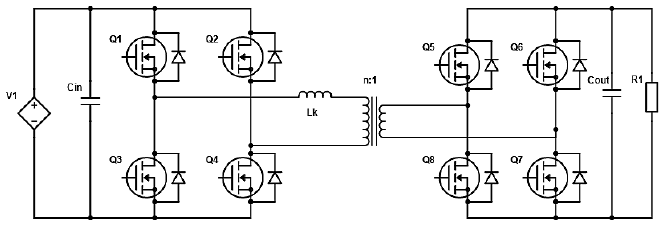
Figure 2. DAB–DC/DC converter topology.